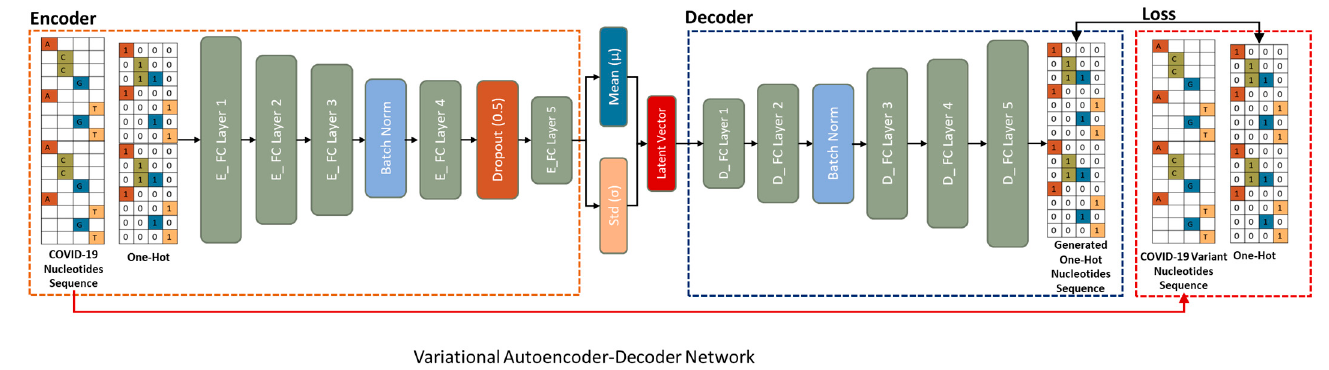
Figure 3. The proposed VAE network for COVID-19 variant generation. The network takes the original COVID-19 nucleotide sequence as the input and outputs a predicted COVID-19 variant. The reconstruction loss is calculated between the variant of COVID-19 not with the original sequence because we want to converge our model to generate different variants.